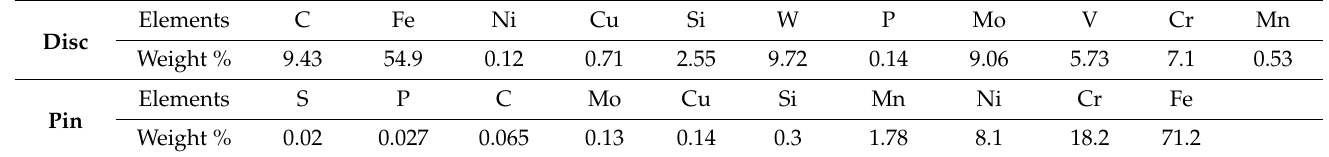
Table 1. Composition of disc and pin material [35].